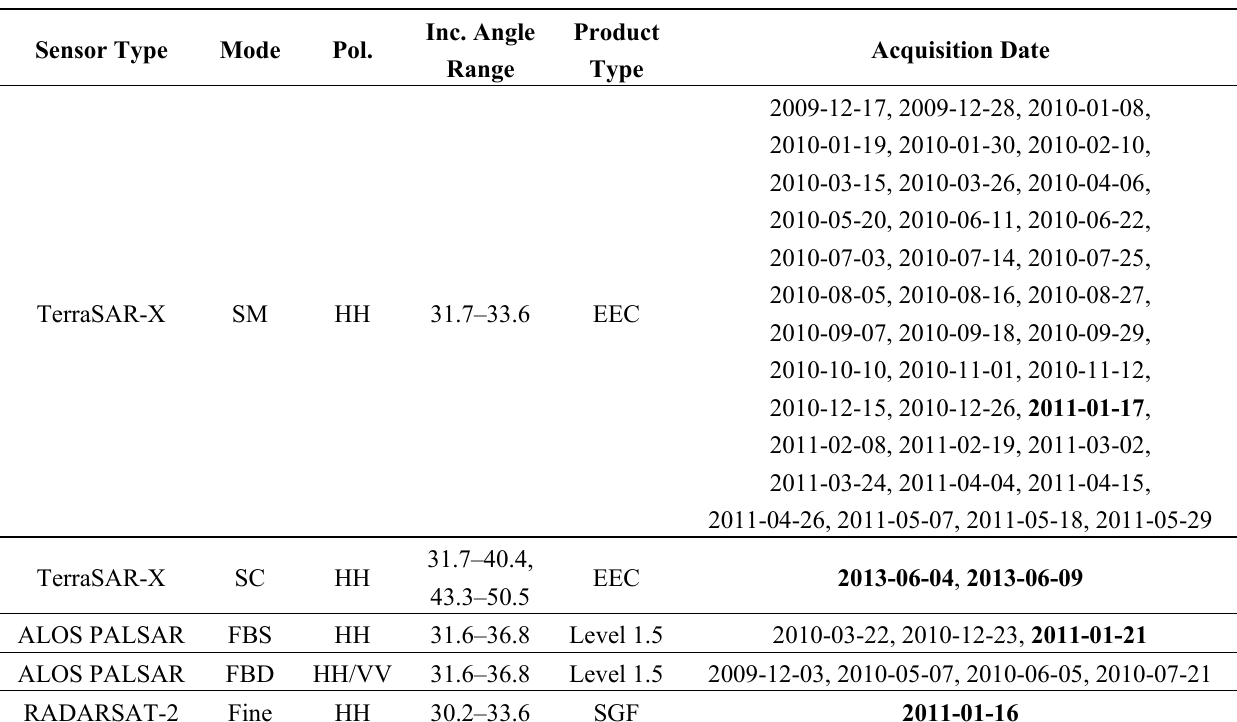
Table 2. Acquisition parameters of SAR data analyzed in this case study including (Pol. = polarization, Inc. angle = incidence angle). Data sets acquired during flood events are marked in